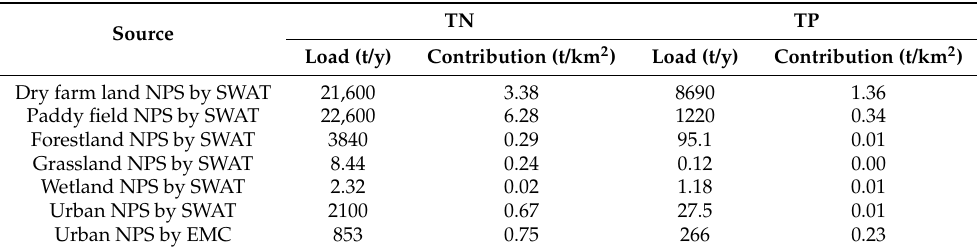
Table 1. The average annual and per unit area yield of total nitrogen (TN) and total phosphorus (TP) from different land use types simulated by the Soil and Water Assessment Tool (SWAT) and the event mean concentration (EMC)